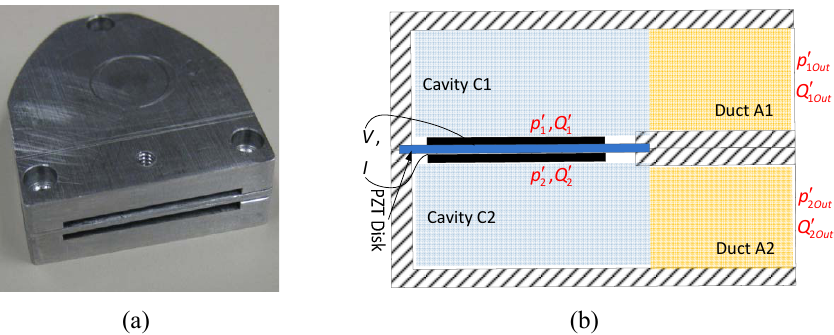
Fig. 12 A synthetic-jet actuator with dual cavities: (a). the picture of the actuator; (b). the schematic used to derive the TM of the